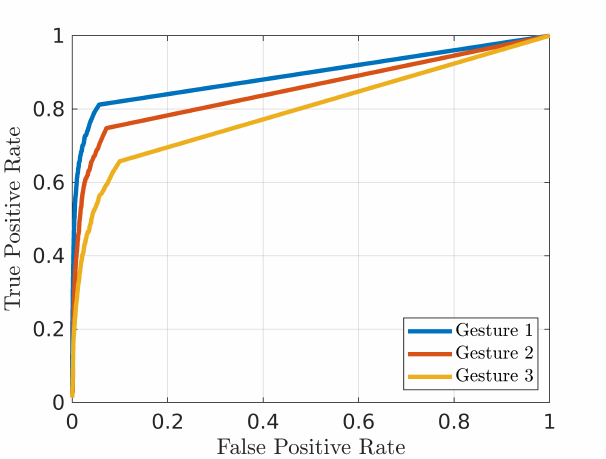
Figure 8. ROC of the three considered gestures. Each curve is averaged on the 25 subjects.